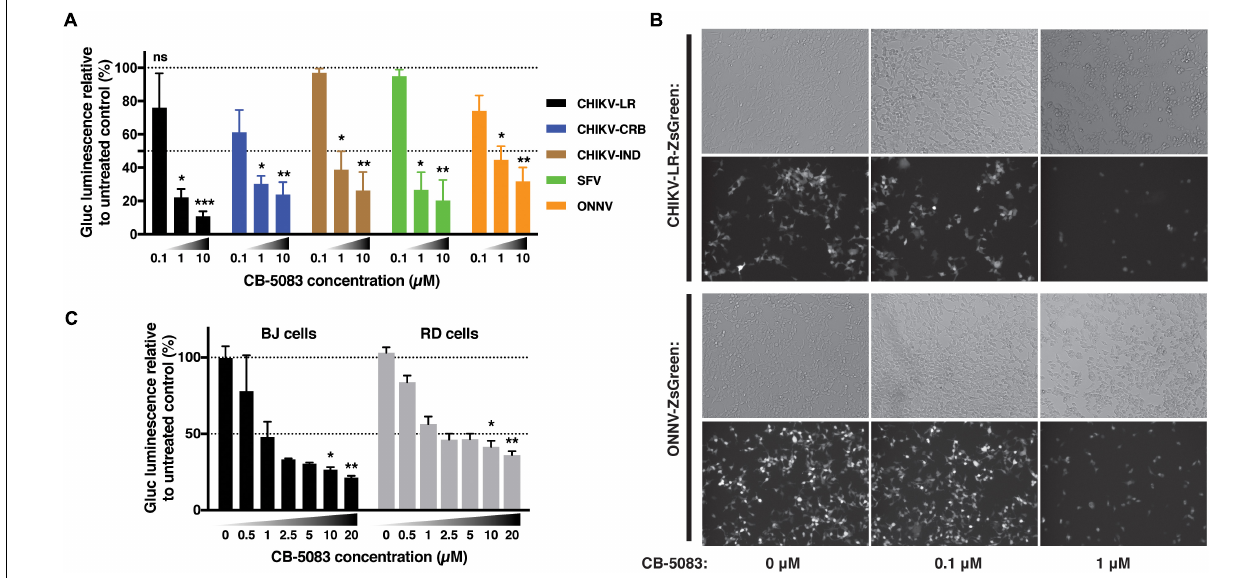
FIGURE 7 | VCP is proviral for other alphaviruses and in other cell types. (A) Thirty thousand HEK 293T cells per well were treated with increasing concentrations of CB-5083 (0, 0.1, 1, and 10 µ M) and infected by 3,000 pfu/well of the indicated viruses each tagged with Gluc, virus inoculum was not removed. At 16 hpi, luminescence in 50 µ L of supernatant was assessed, results are expressed to their relative 0 µ M treatment. (B) Representative epi-fluorescence images of 30,000 HEK 293T cells infected by 30,000 pfu of ZsGreen-tagged CHIKV-LR and ONNV for 16 h at different CB-5083 concentration (as indicated on the figure). Images are representative of three independent experiments and were acquired on brightfield (auto exposure) and FITC (fixed exposure) channels. (C) 5,000 RD or BJ cells per well were treated with increasing concentrations of CB-5083 (indicated on the figure) and infected by 5,000 pfu of CHIKV-LR-tagged with Gluc, virus inoculum was not removed. At 16 hpi, luminescence in 50 µ L of supernatant was assessed. Data of panels A and B are representative of four and three independent experiment, respectively, presented as mean ± SD and were analyzed by Mann–Whitney non-parametric two-tailed test; ∗ p < 0.05, ∗∗ p < 0.01, ∗∗∗ p <